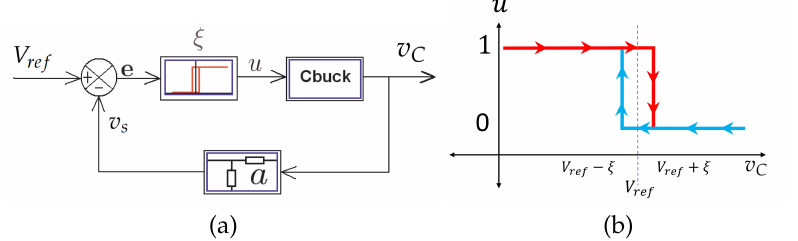
Figure 12. Hysteresis control applied to the Buck converter ( a ) block diagram with the constant hysteresis control and ( b ) switching state for the constant hysteresis control ( ξ > 0).